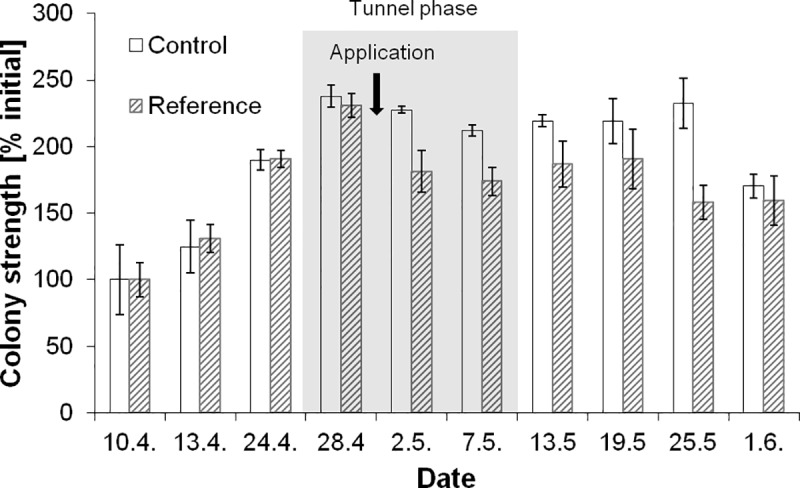
Colony strength [% initial] obtained from the estimations of the numbers of adult bees measured by weight.Error bars reflect the standard deviation between colonies (data had been normalised to the mean of the control group).